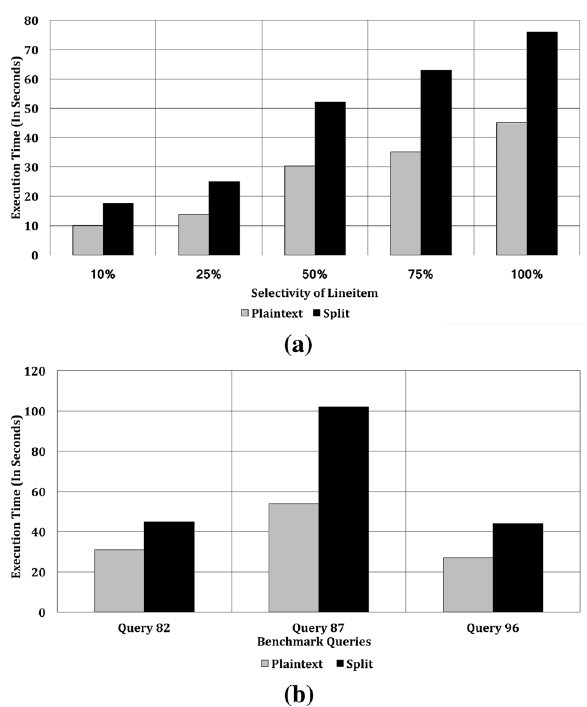
Fig. 8 Query execution time on benchmark databases. a 10GB TPC-H database. b 10GB TPC-DS